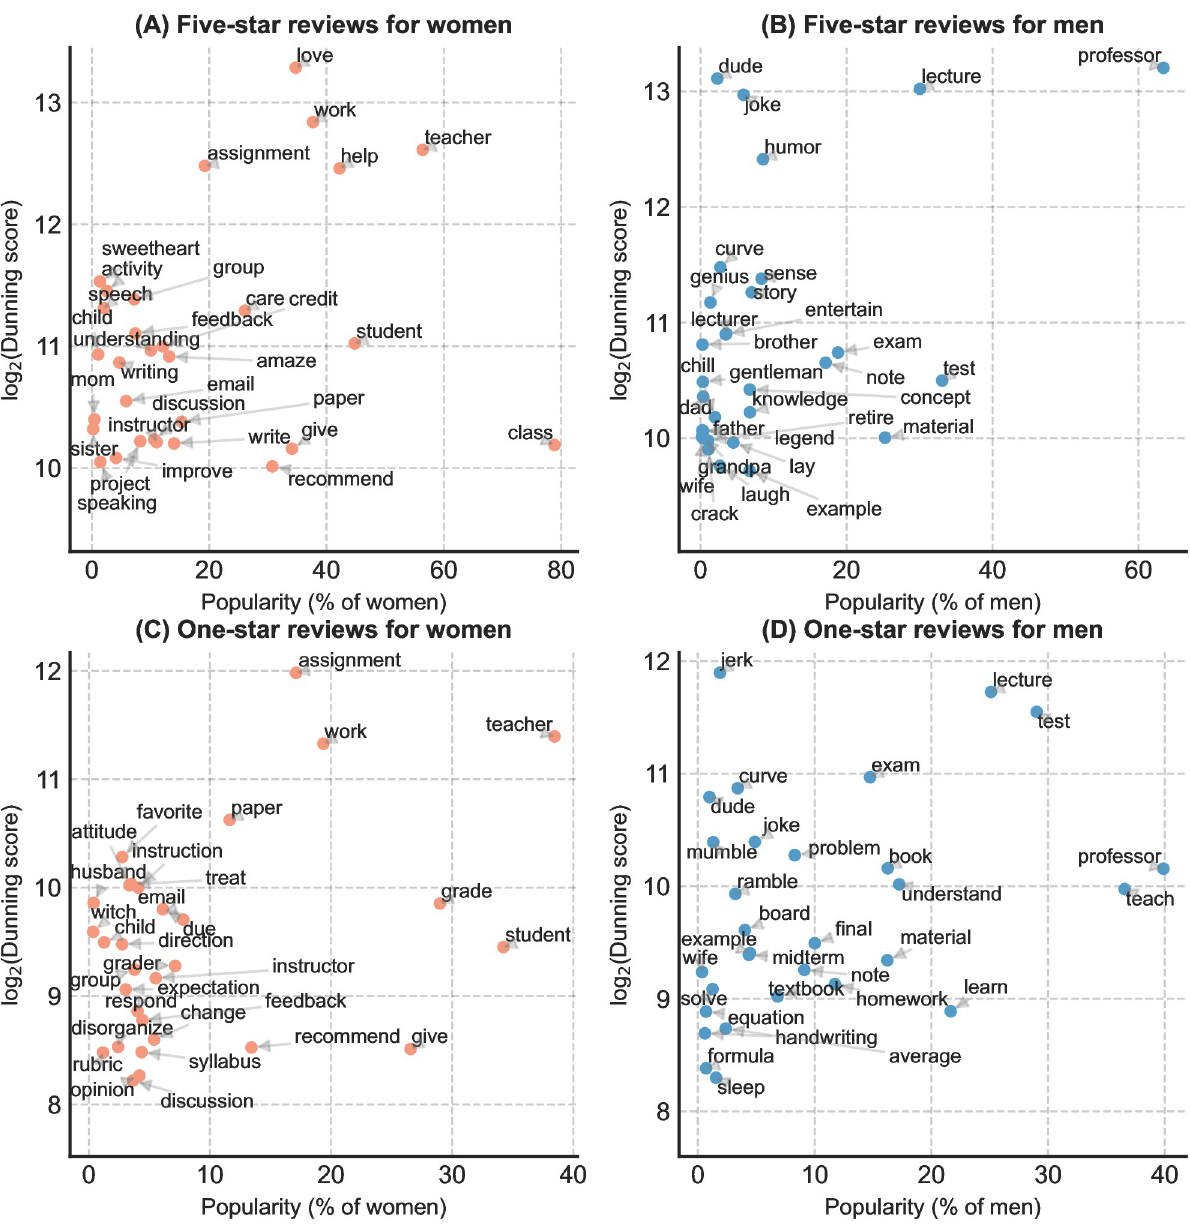
Fig 6. Dunning score and popularity of the top 30 gender-distinct non-adjectives in RMP comments by gender and rating. The popularity of a word is the percentage of professors whose comments contain the word. (A) In five-star reviews for women. (B) In five-star reviews for men. (C) In one-star reviews for women. (D) In one-star reviews for